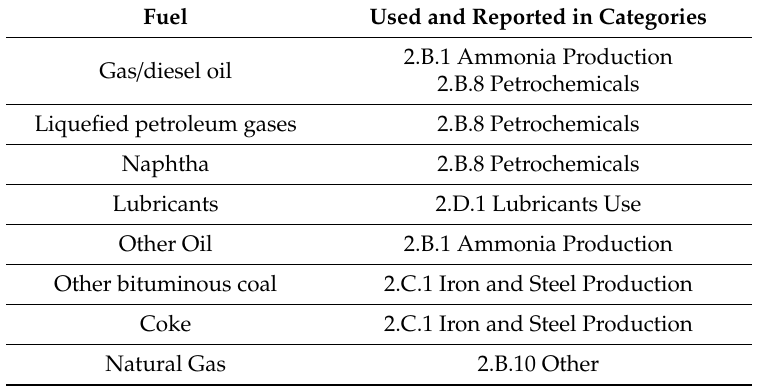
Table 3. The allocation of non-energy use of fuels in the IPPU sector in the Czech Republic.